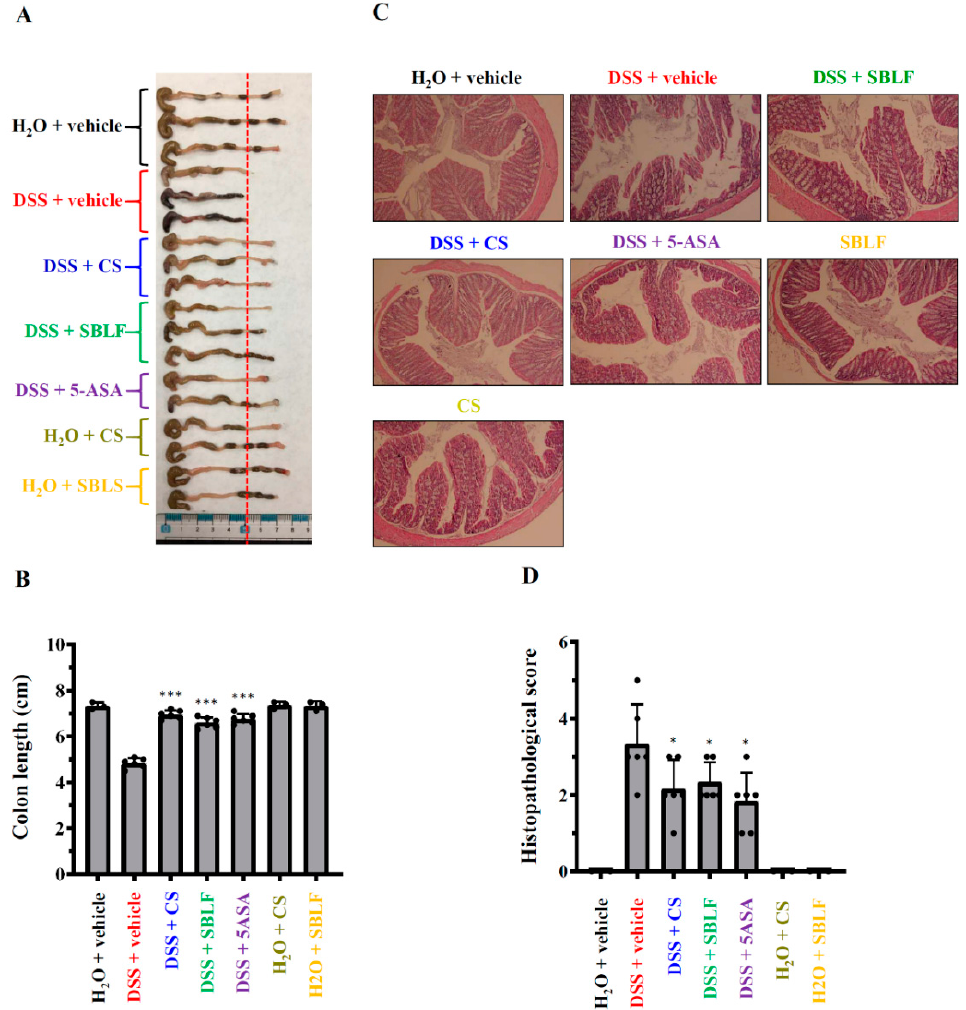
Figure 2. SBLF improves colon damage in DSS-treated mice. ( A ) Images of representative colon from mice. ( B ) Bars represent the colon length of mice. ( C ) Images of representative H&E stained colon sections from mice. ( D ) Histopathological score for the colon from mice. Bars show the mean ± SD. * p < 0.05 and *** p < 0.001 compared to vehicle + DSS group.